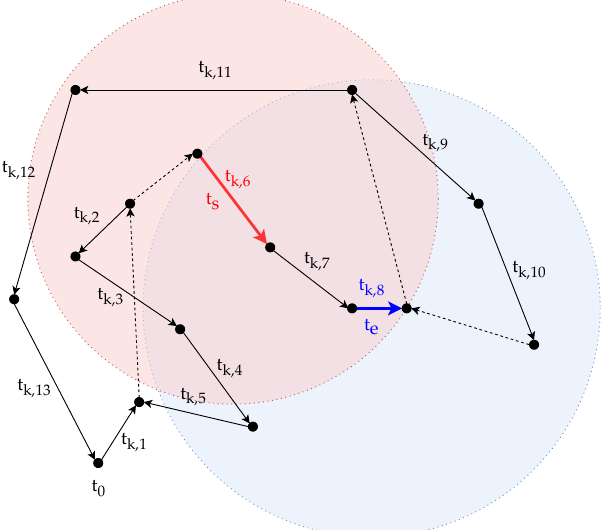
Figure 4. Nearest neighbors of the arc tasks t k , s ( t k ,6 ) and t k , e ( t k ,8 ) within the route plan r k , when n max = 5.